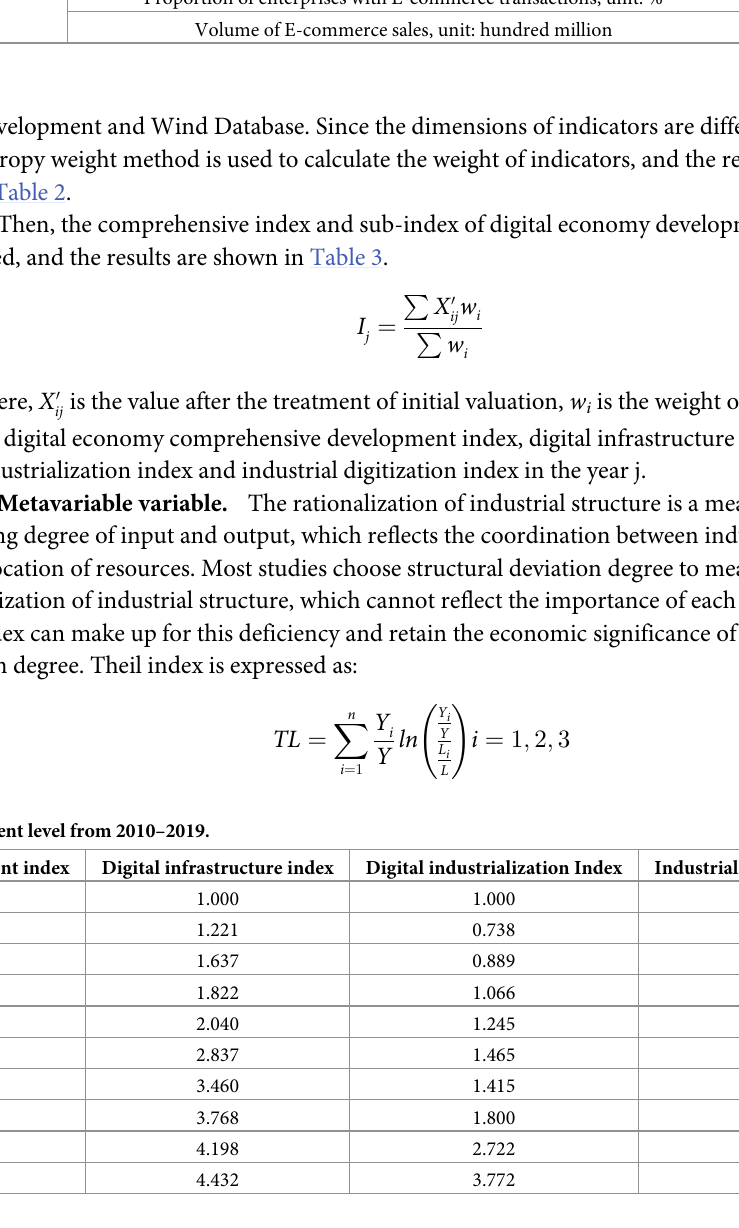
Development and Wind Database. Since the dimensions of indicators are different, the entropy weight method is used to calculate the weight of indicators, and the results are shown in Table 2. Then, the comprehensive index and sub-index of digital economy development are calcu- lated, and the results are shown in Table 3.